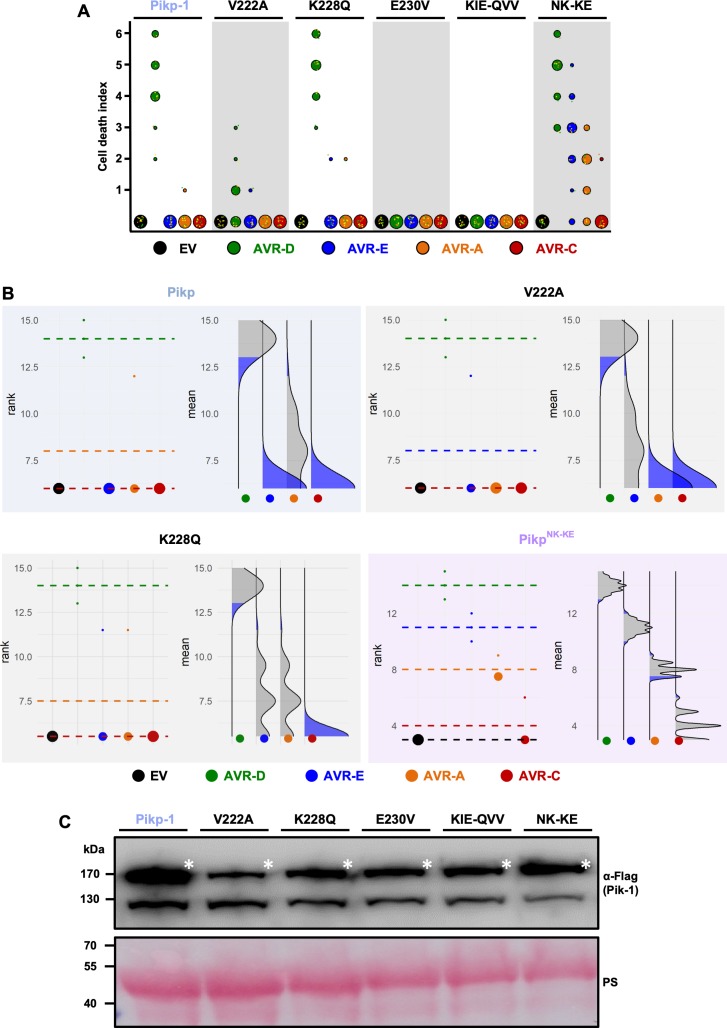
Mutations at interface 2 of the Pikp-1 HMA domain compromise the response to AVR-Pik effectors.(A) Cell-death assay scoring represented as dot plots for Pikp-1 mutants with mutations on HMA interface 2 and 3. For each sample, all of the data points are represented as dots with a distinct color for each of the three biological replicates; these dots are plotted around the cell death score for visualization purposes. The size of the central dot at each cell death value is proportional to the number of replicates of the sample with that score. The number of repeats was 18 for each mutant. (B) Statistical analysis by estimation methods of the cell death assay for Pikp-1 mutants. The left panel represents the ranked data (dots) for each effector, and their corresponding mean (dotted line). The size of the dots is proportional to the number of observations with that value. The right panel shows the distribution of 1000 bootstrap sample rank means for each effector. The blue areas represent the 0.025 and 0.975 percentiles of the distribution. A sample (effector) score is considered significantly different from the control (EV) when the control rank mean (dotted line on the left) falls beyond the blue regions of the effector mean distribution. When the rank means for different effectors have the same value, only one dotted line is visible (EV, AVR-E and AVR-C for Pikp and K228Q, and EV, AVR-A and AVR-C for V222A). (C) Western blot analysis confirming similar levels of Pik-1 protein accumulation in N. benthamiana. The asterisks mark the Pik-1 band, PS = Ponceau Stain.
10.7554/eLife.47713.004Figure 1—figure supplement 1—source data 1.Cell death scoring data used in the preparation of Figure 1—figure supplement 1A.